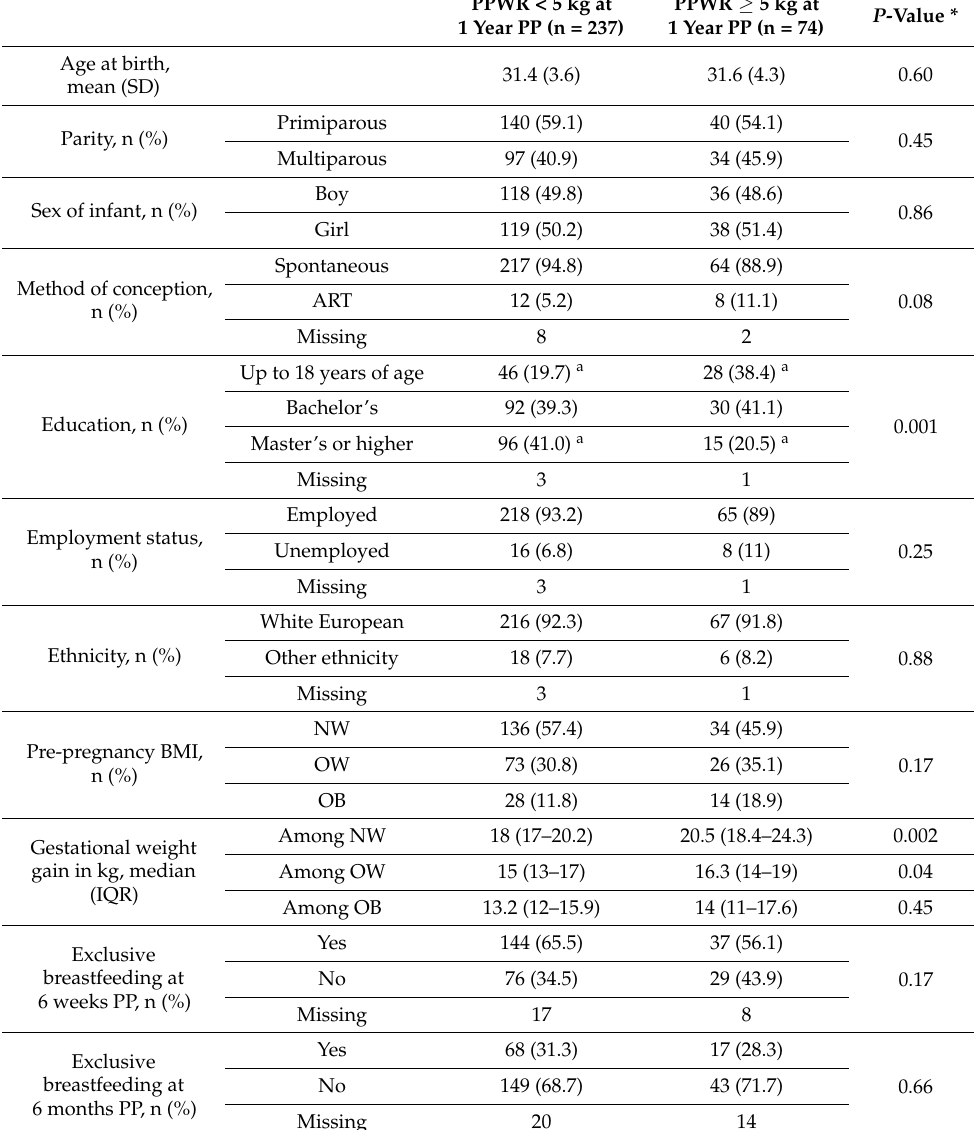
Table 2. Differences between participants with <5 kg and ≥ 5 kg postpartum weight retention at 12 months postpartum (N =